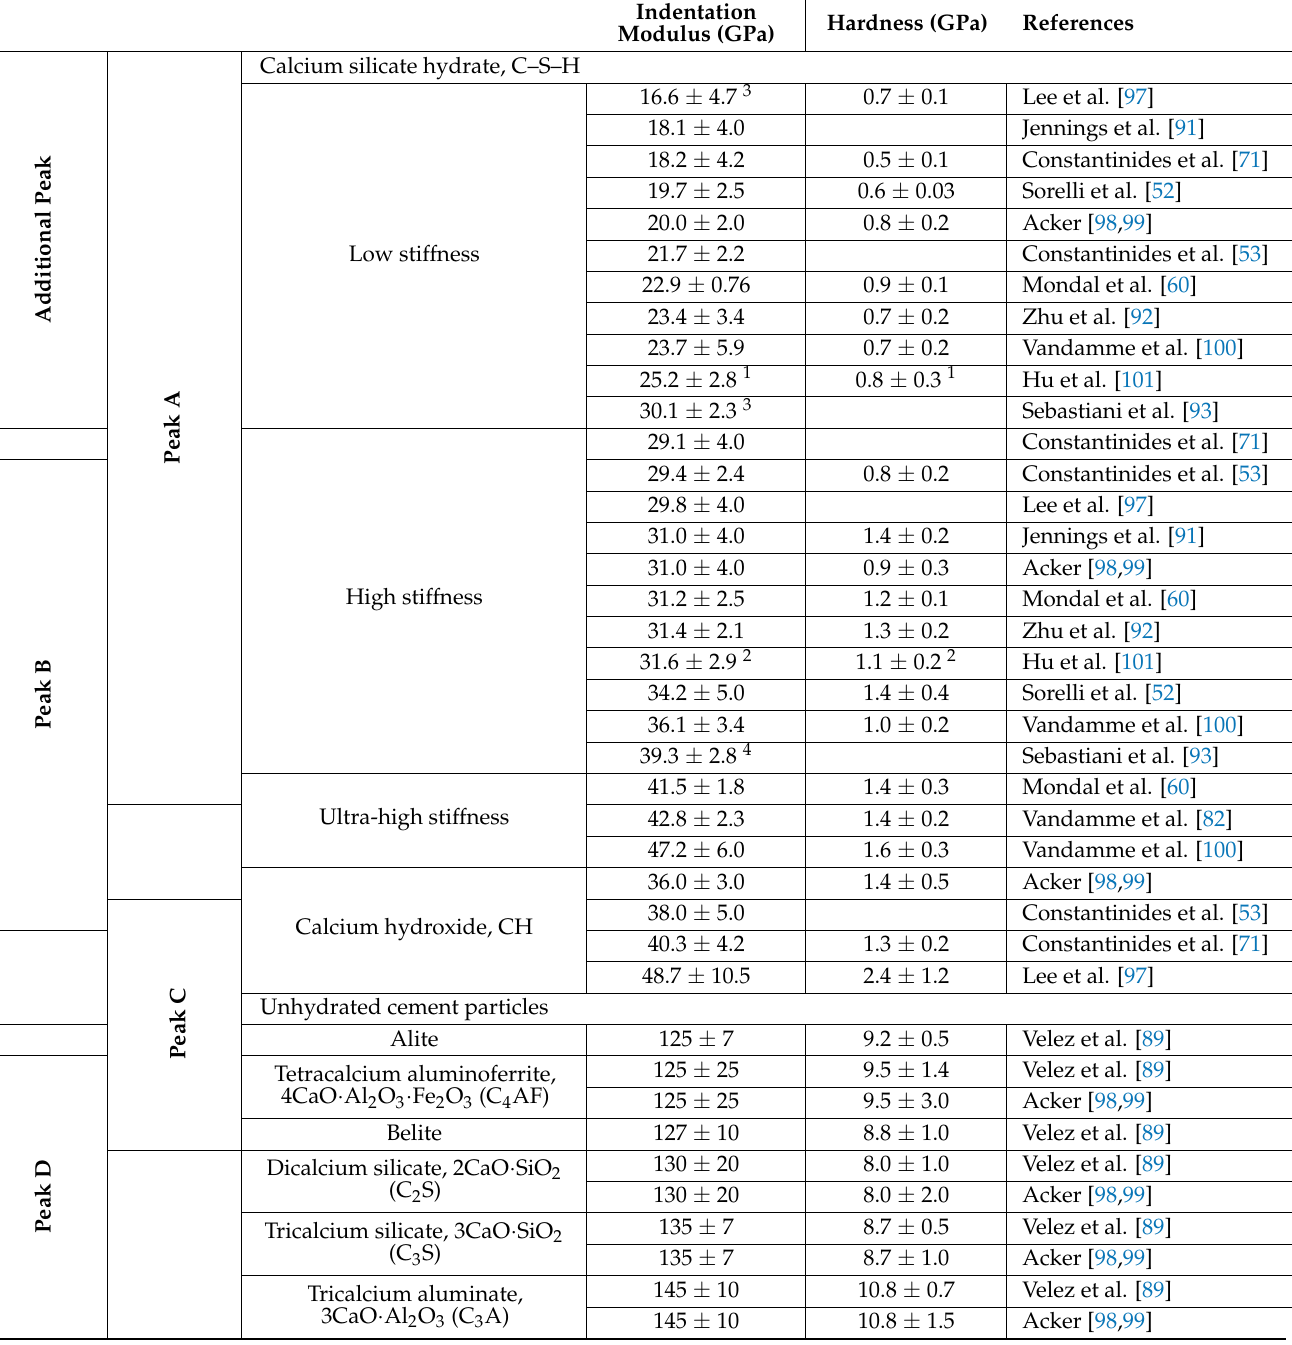
Table 2. Classification of mechanically distinct phases (Additional Peak and Peaks A–D, this study) with their corresponding chemical phases as determined from indentation modulus and hardness measurements of cement phases reported in the literature from